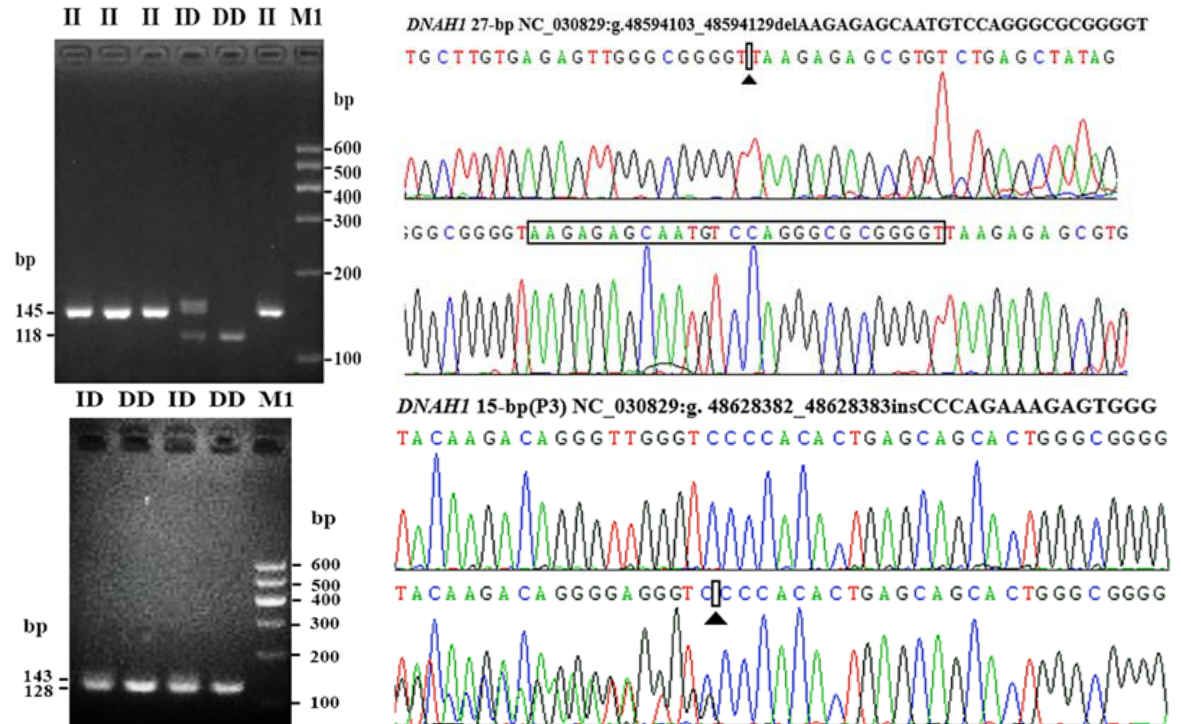
Figure 3. Electrophoresis and sequence diagrams of P1 and P3 InDel loci of DNAH1 gene in Shaanbei white cashmere goat. The P1 locus is the result of II and DD genotype sequencing. P3 is the DD and ID genotype sequencing result.